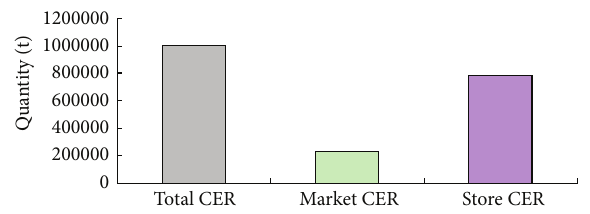
Figure 5: The scenario of reformed market CER and reserved CER [18].